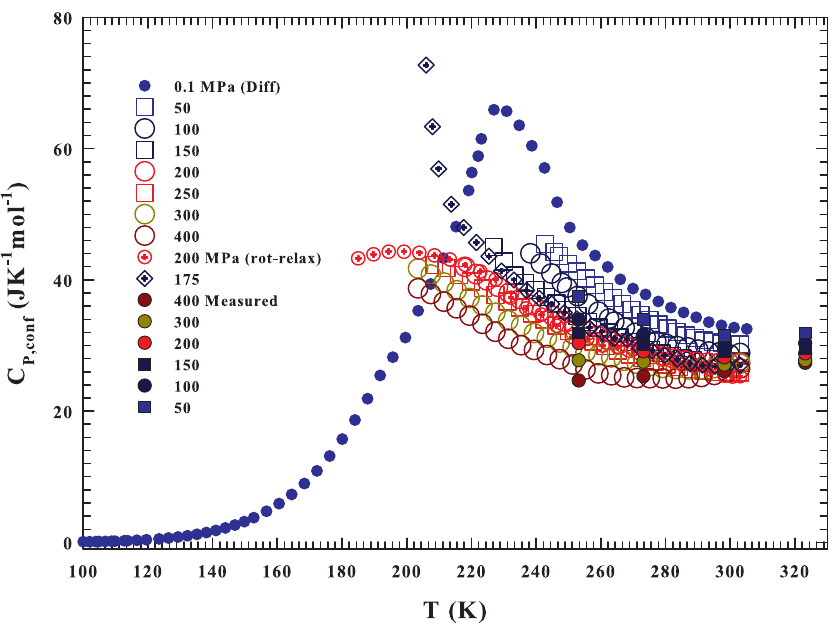
Figure 7. The C P , conf isobars calculated according to the AG procedure by using the bulk water transport data, in the P range 0.1–400 MPa, are shown. For comparison, the bulk water experimentally measured ∆ C P at 50, 100, 150, 200, 300 and 400 MPa, are also reported